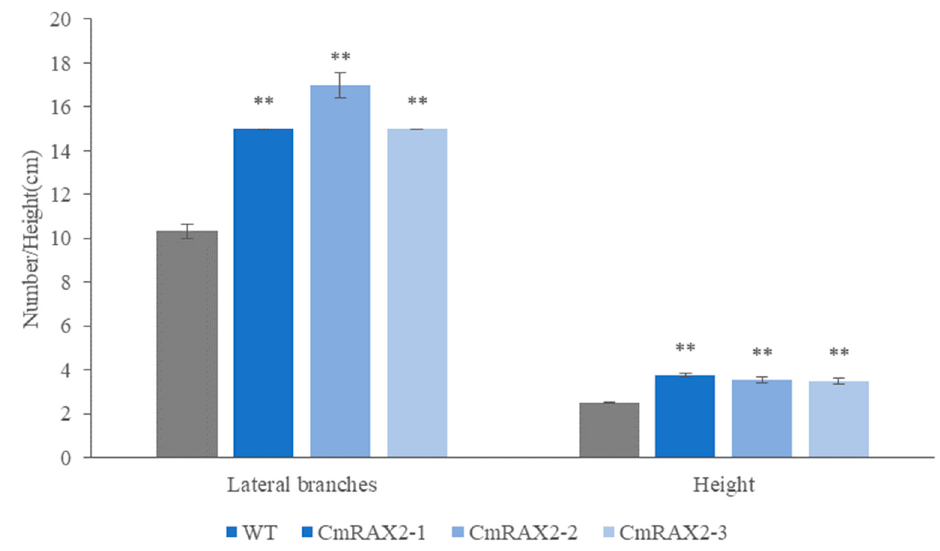
Figure 8. Effect of CmRAX2 on the number of lateral branches and plant height of chrysanthemum ‘Jinba’. The lines are used to show standard errors. The ** means significantly higher than wild-type plants.